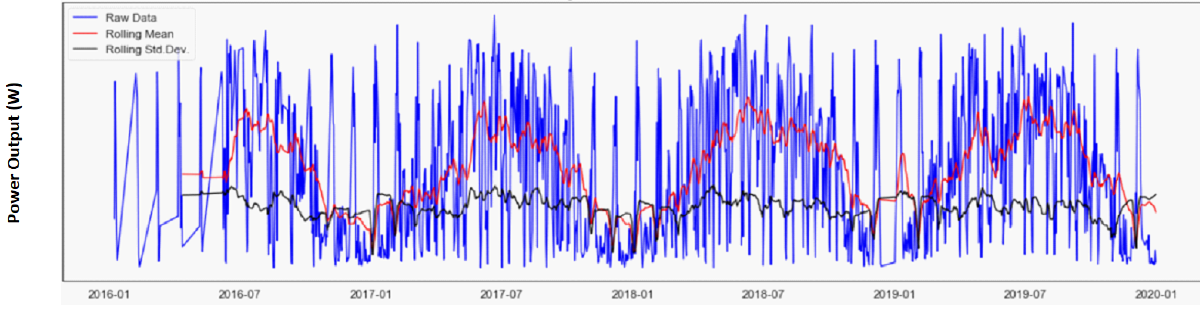
Figure 6: Plot of the raw data with the rolling mean (24 hour window) and standard